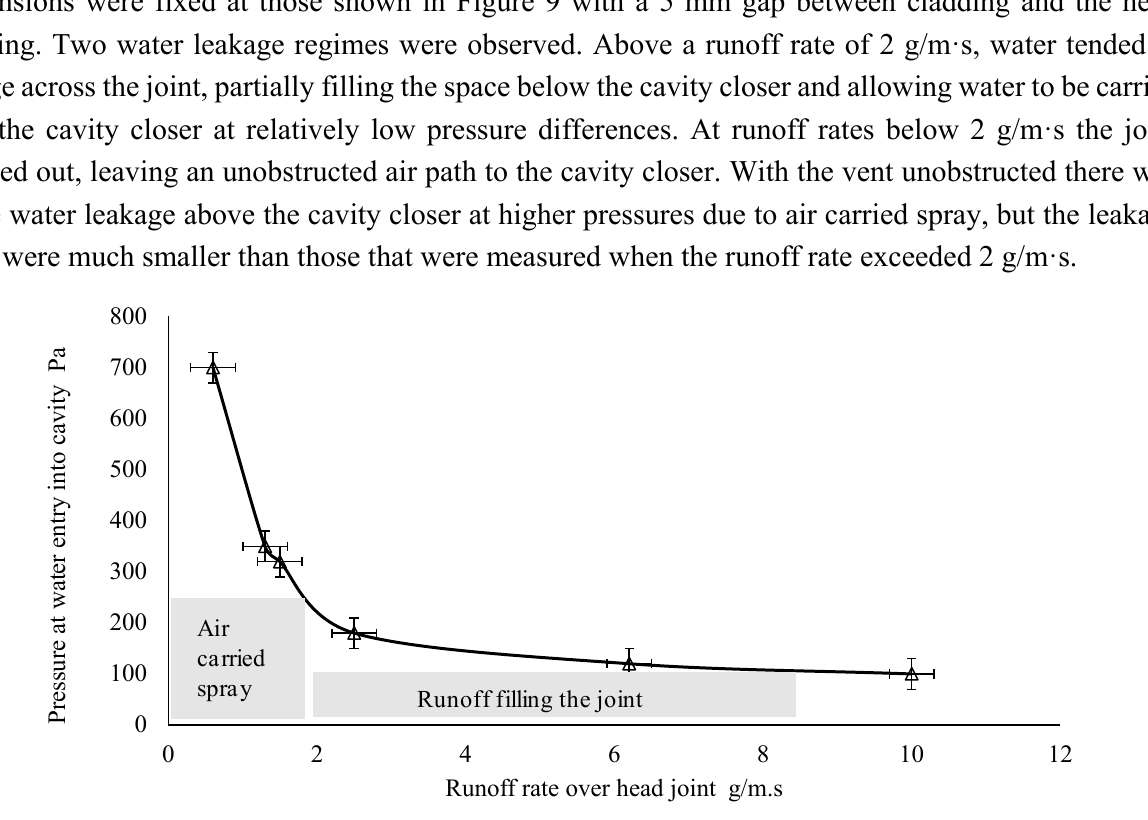
Figure 11. Pressure difference at the onset of leakage through a window head joint as a function of runoff rate over the